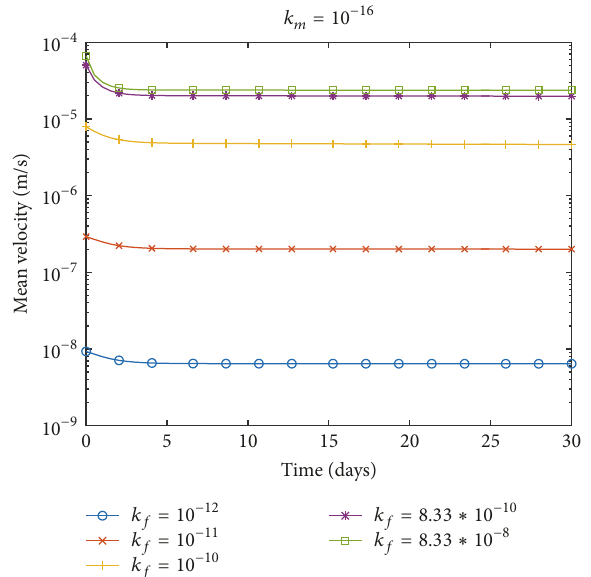
Figure 5: Mean fracture velocity during the simulated 30 days of injection.